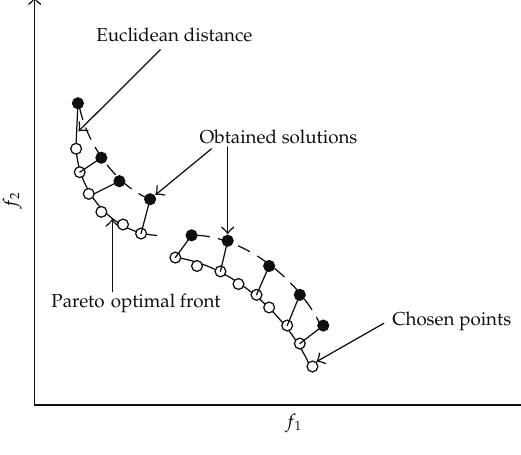
Figure 4: Convergence metric Υ